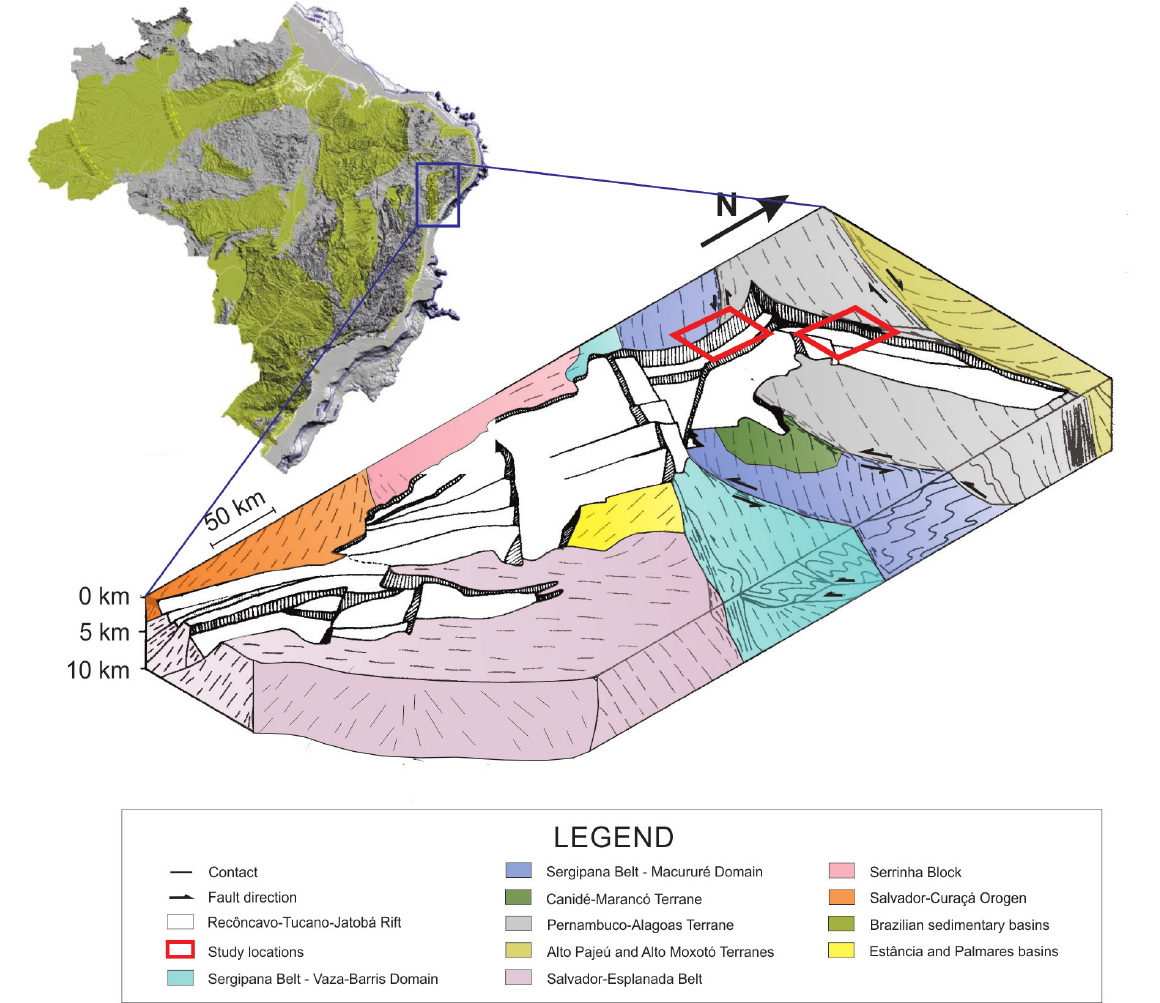
Figure 1. Architecture and structures of the Recôncavo-Tucano-Jatobá Rift basement (adapted by Milani & Davison 1988, modified from Milani et al.